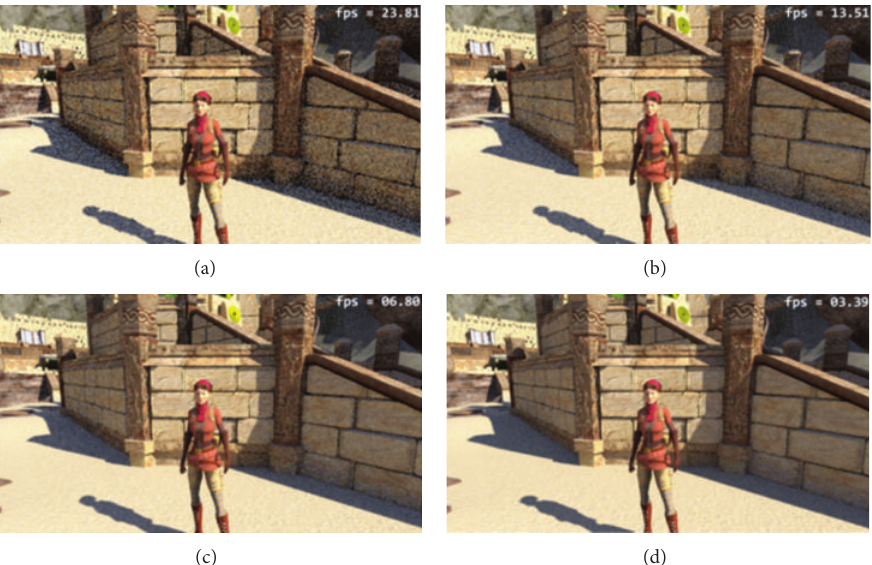
Figure 14: Noise level and performance at 2 spp, 4spp, 8spp, and 16spp. Rendering resolution is 640 × 360 . Measured on a system with a 6-core CPU and two NVidia GTX470